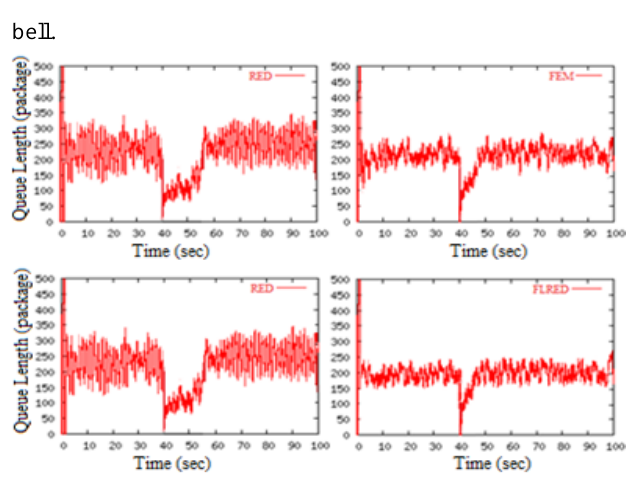
Figure 9,. Ability to respond of RED, FEM and FLRED Similarly, Figure 10 represents ability to respond the queue management mechanism based on queue length and flow rate to, FLREM have a shorter recovery time than FUZREM.